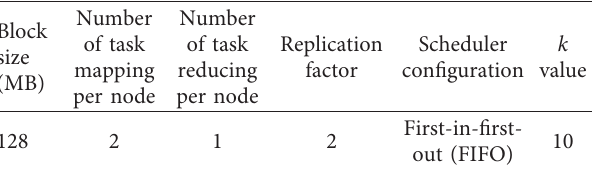
Figure 2: Experimental setup of Hadoop nodes. Table 3: Configuration of Hadoop parameters.